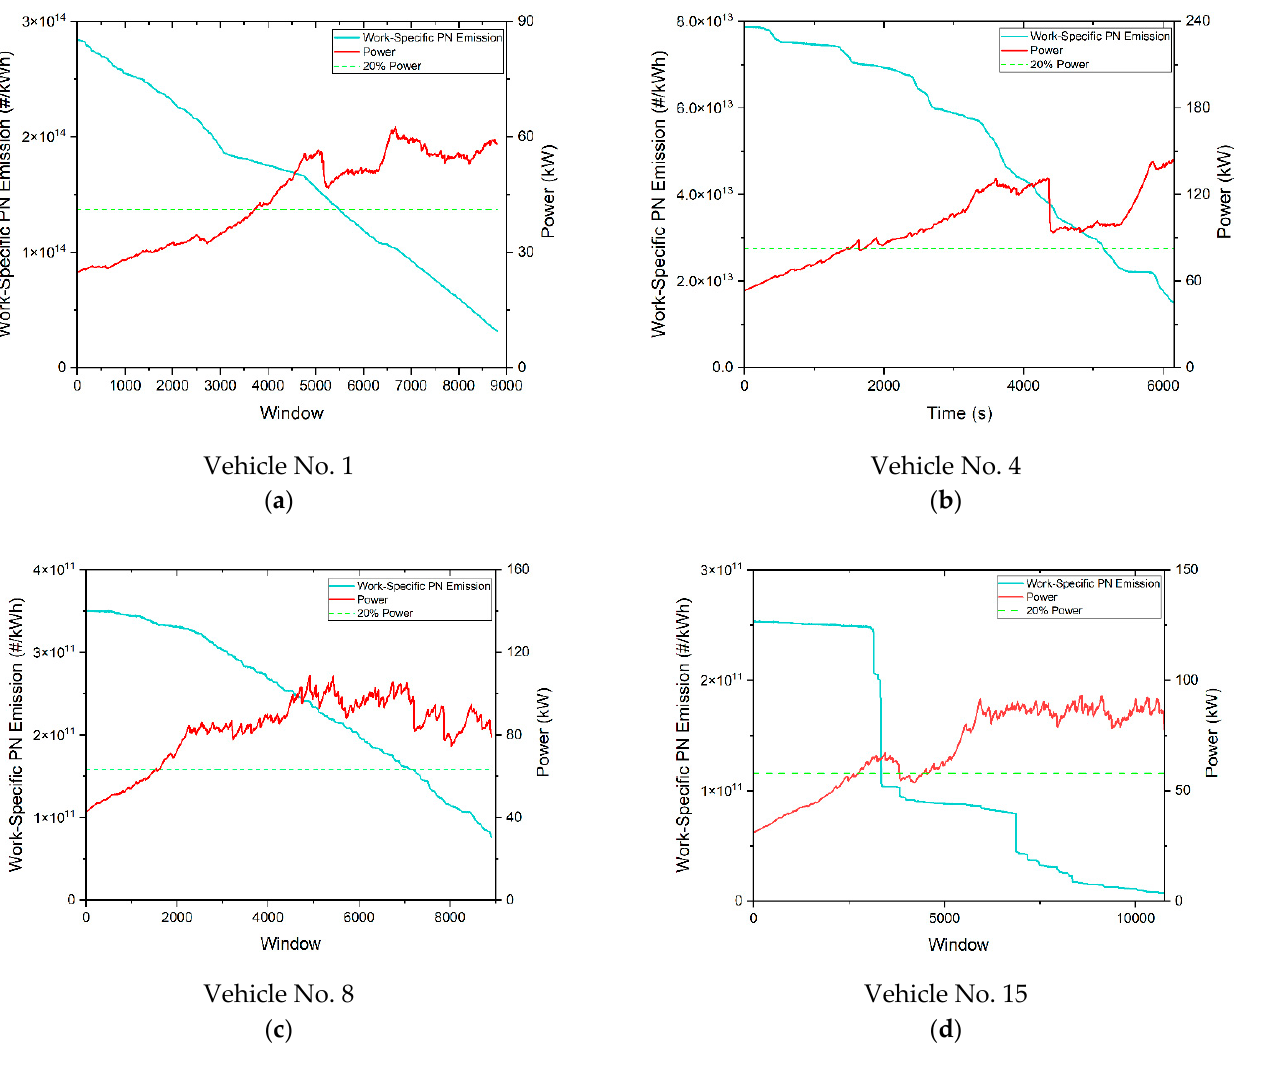
Figure A3. The relationship between the work-based window PN emission and the power change with the window of a typical test vehicle. ( a ) China-5 diesel vehicle; ( b ) China-6 diesel vehicles with malfunctioning DPFs; ( c ) China-6 diesel vehicles with intact DPFs; ( d ) China-6 NG vehicles.